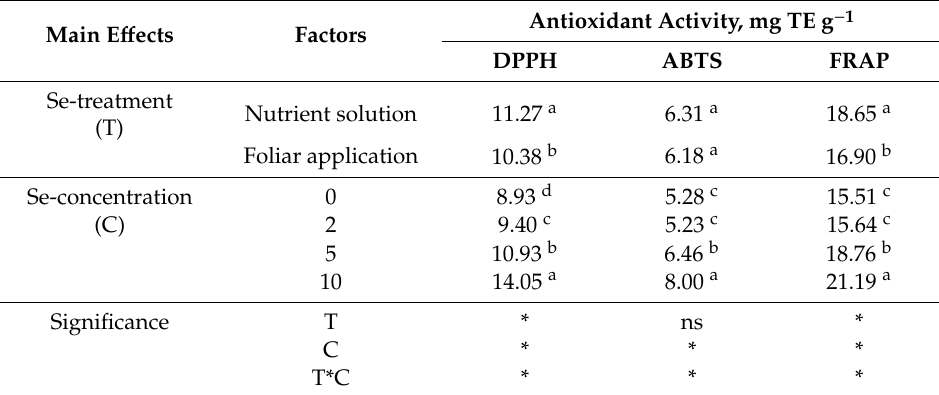
Table A3. Results of 2-factorial ANOVA for antioxidant